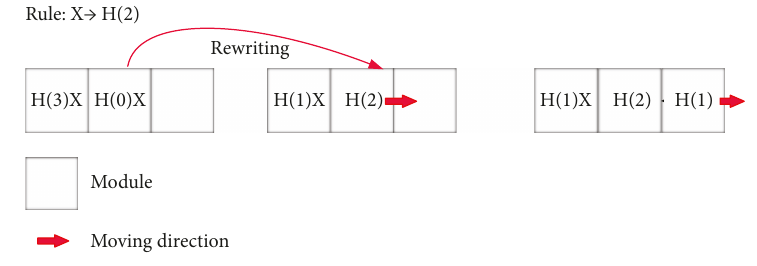
Figure 6: Robotic structures develop by attaching new modules at the growing direction.